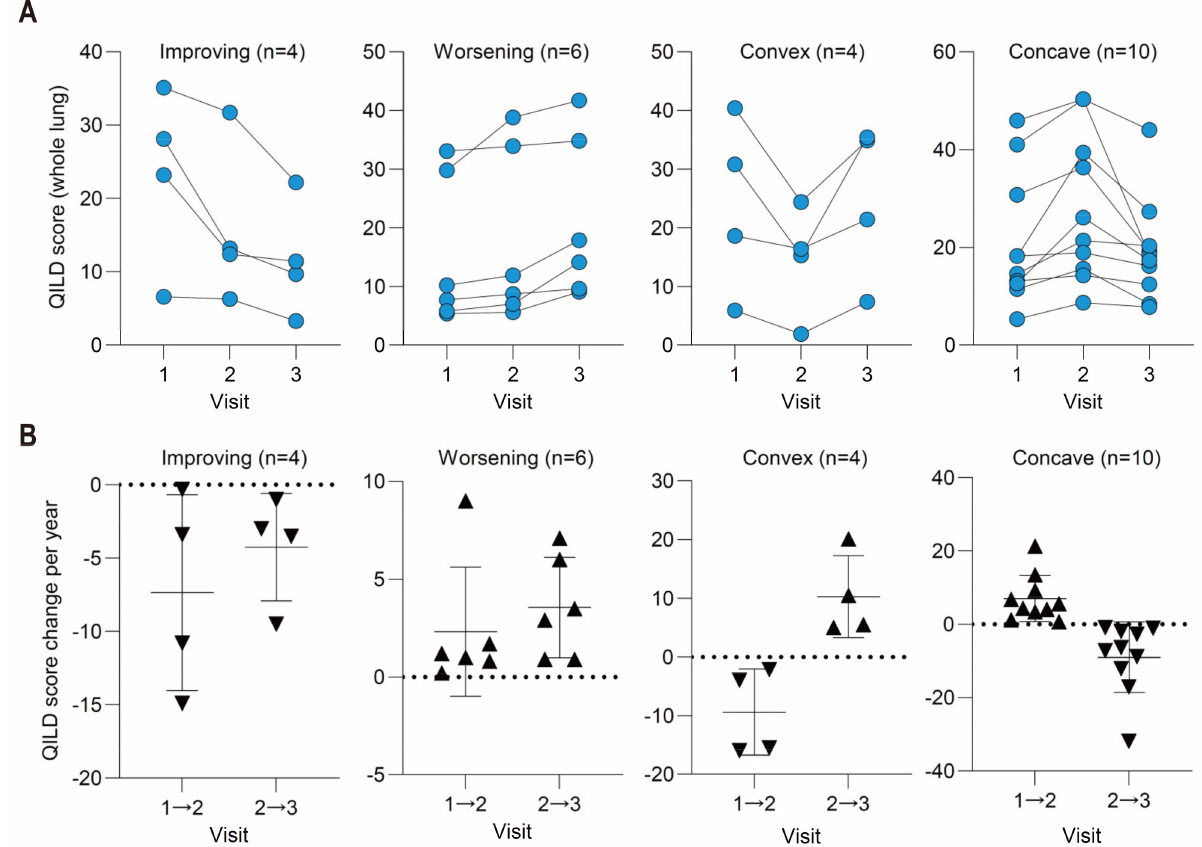
Figure 5. Four distinct patterns of change in 3 longitudinally obtained QILD scores (cohort 2, n = 24). ( A ) Whole lung QILD scores were depicted as four patterns of change: Improving ( n = 4), worsening ( n = 6), convex-like dynamic change ( n = 4), and concave-like dynamic change ( n = 10). ( B ) Velocity of QILD score change per year between visits 1 and 2 and visits 2 and